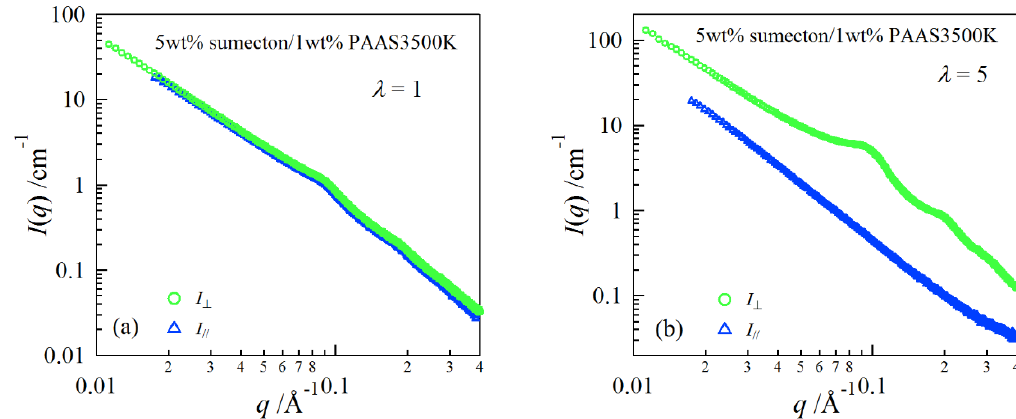
Figure 7. SAXS profiles in the directions parallel and perpendicular to the stretching for a 5 wt % sumecton/PAAS gel at the elongation ratio of 1 ( a ) and 5 ( b ).